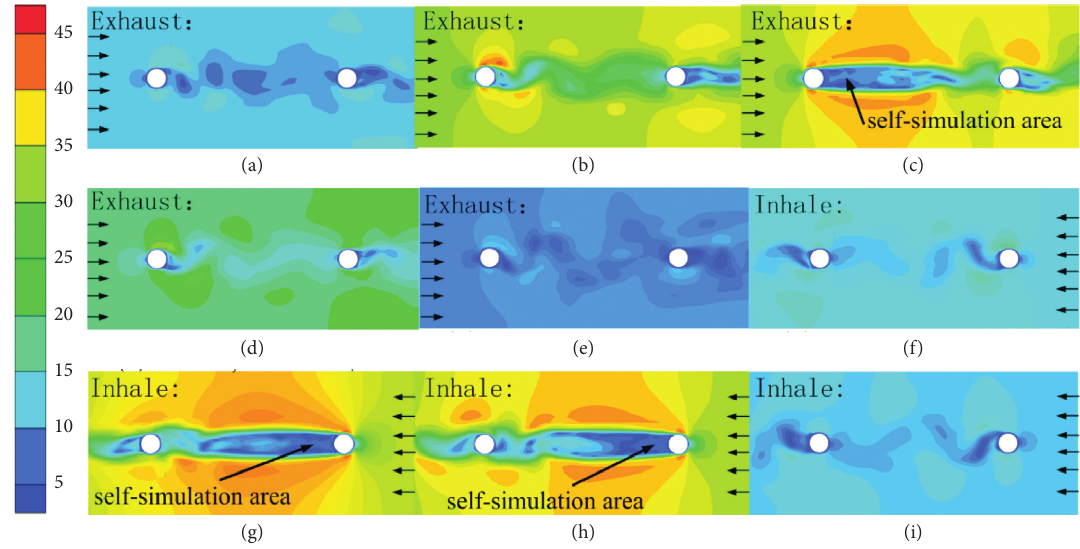
Figure 7: The air velocity cloud images across the bluff body with time. (a) t � 0.2 s, v � 15.68m/s. (b) t � 0.6 s, v � 40.99m/s. (c) t � 1s, v � 45.34m/s. (d) t � 1.4 s, v � 32.81 m/s. (e) t � 1.8, v � 14.19m/s. (f) t � 2.2 s, v � 19.31m/s. (g) t � 2.6s, v � 49.85 m/s. (h) t � 3 s, v � 41.83m/s. (i) t � 3.4s, v � 20.47m/s.